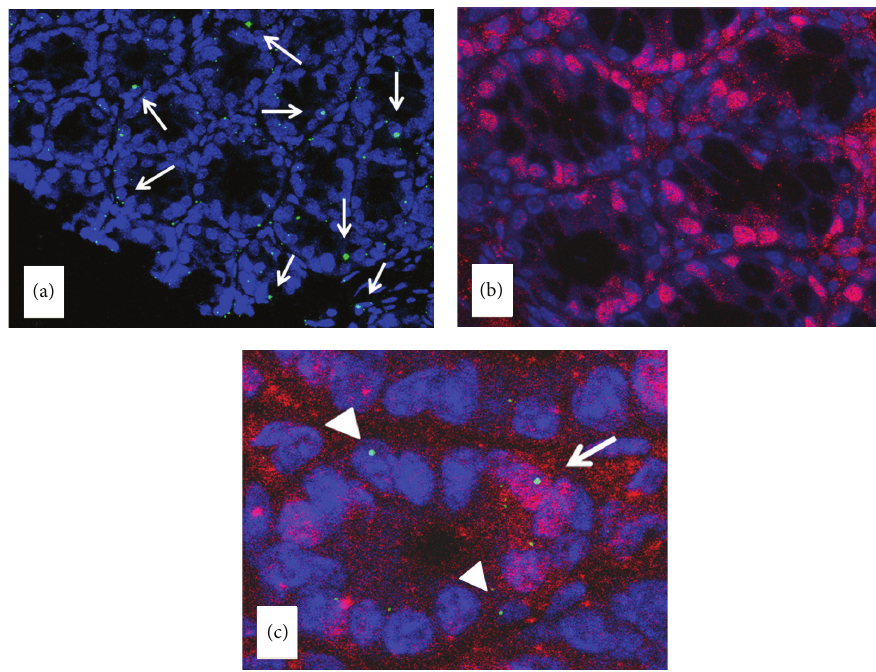
Figure 3: Y-chromosome and CDX-2 distribution in the “normal” mucosa and their colocalization in the nucleus. (a) Y-chromosome, identified by the green spot; (b) Cdx2, identified by the fuchsia intranuclear colour; (c) Y-chromosome, identified by the green spot, not colocalized with Cdx2 (arrow head). Y-chromosome colocalized with Cdx2, identified by the fuchsia intranuclear colour (arrows).